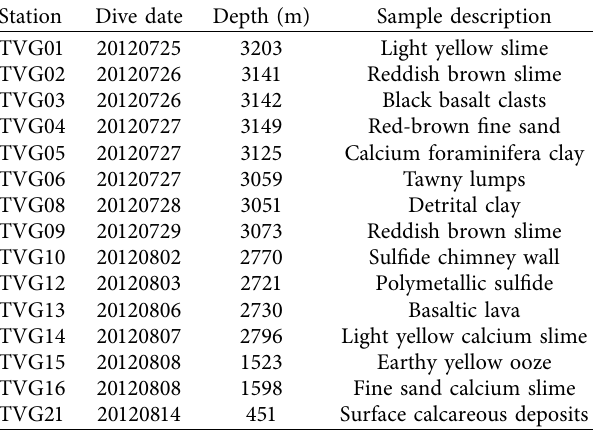
Figure 3: Schematic diagram of grid reorganization. Table 2: Sampling stations, dive date, depths, and sample